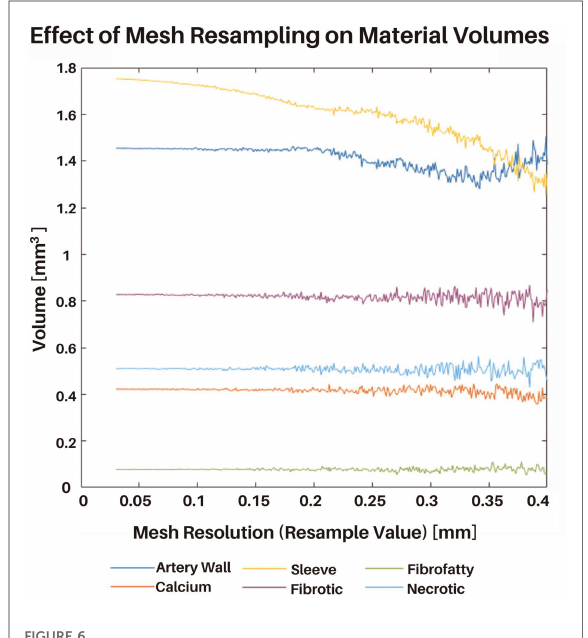
FIGURE 6 Mesh convergence study. An entire representative artery was reconstructed at various mesh resolutions. Meshing resolutions ranging from 0.04 mm to 0.4 mm in steps of 0.005 were used (x- axis). The total volume of each plaque constituent was calculated at each resolution